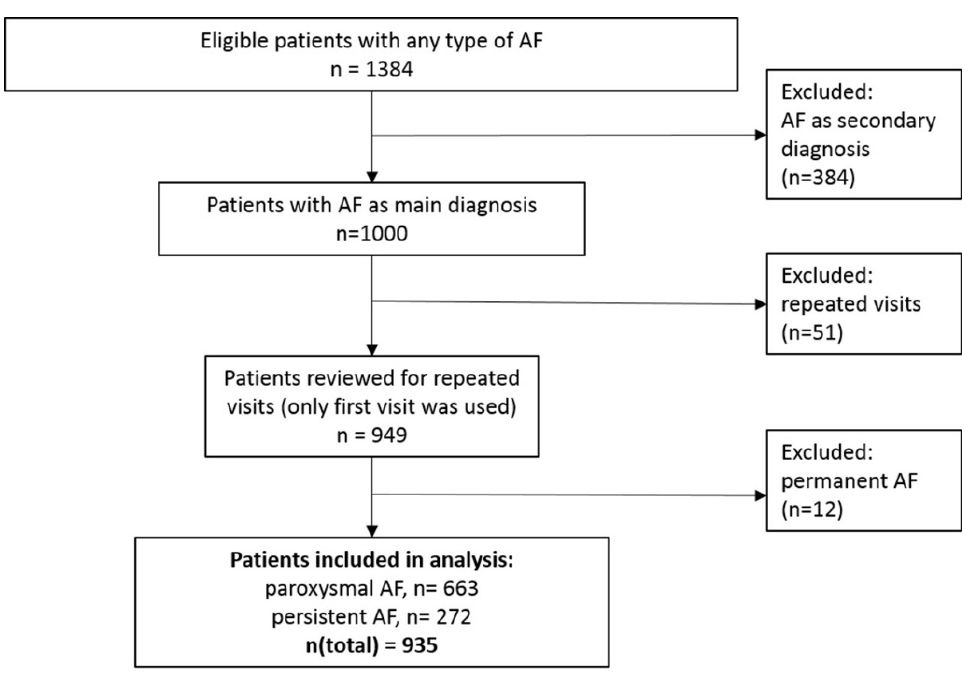
Figure 1. Study flow of HAMBURG-AF.